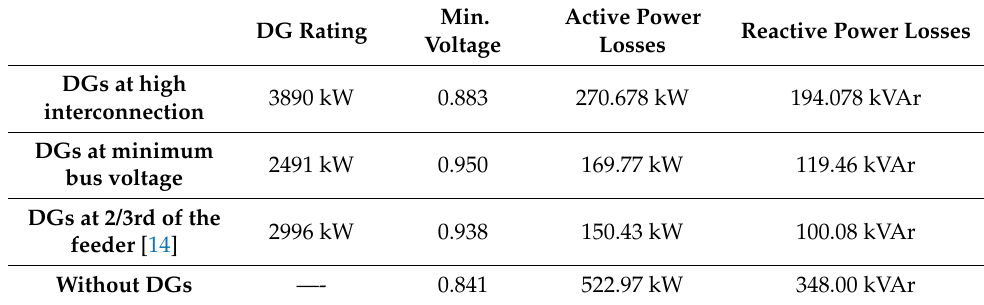
Table 7. Summary of the load flow results at 150% loading, or a total connected load of (5371.5 + j2617.5) kVA.